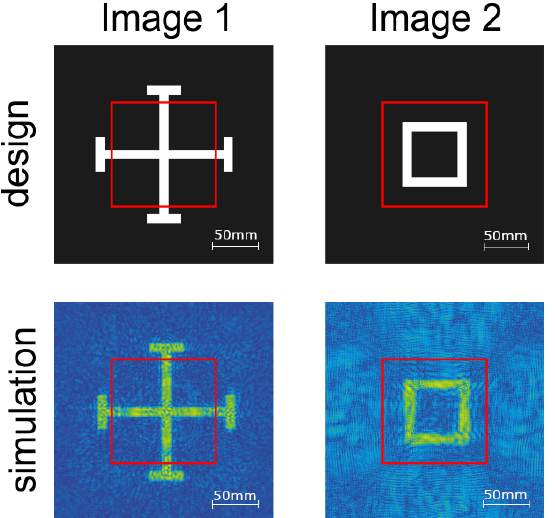
Figure 4. Manufactured hologram ( left ) and its phase distribution ( right ), where black color denotes the 0 π phase shift and white 2 π .